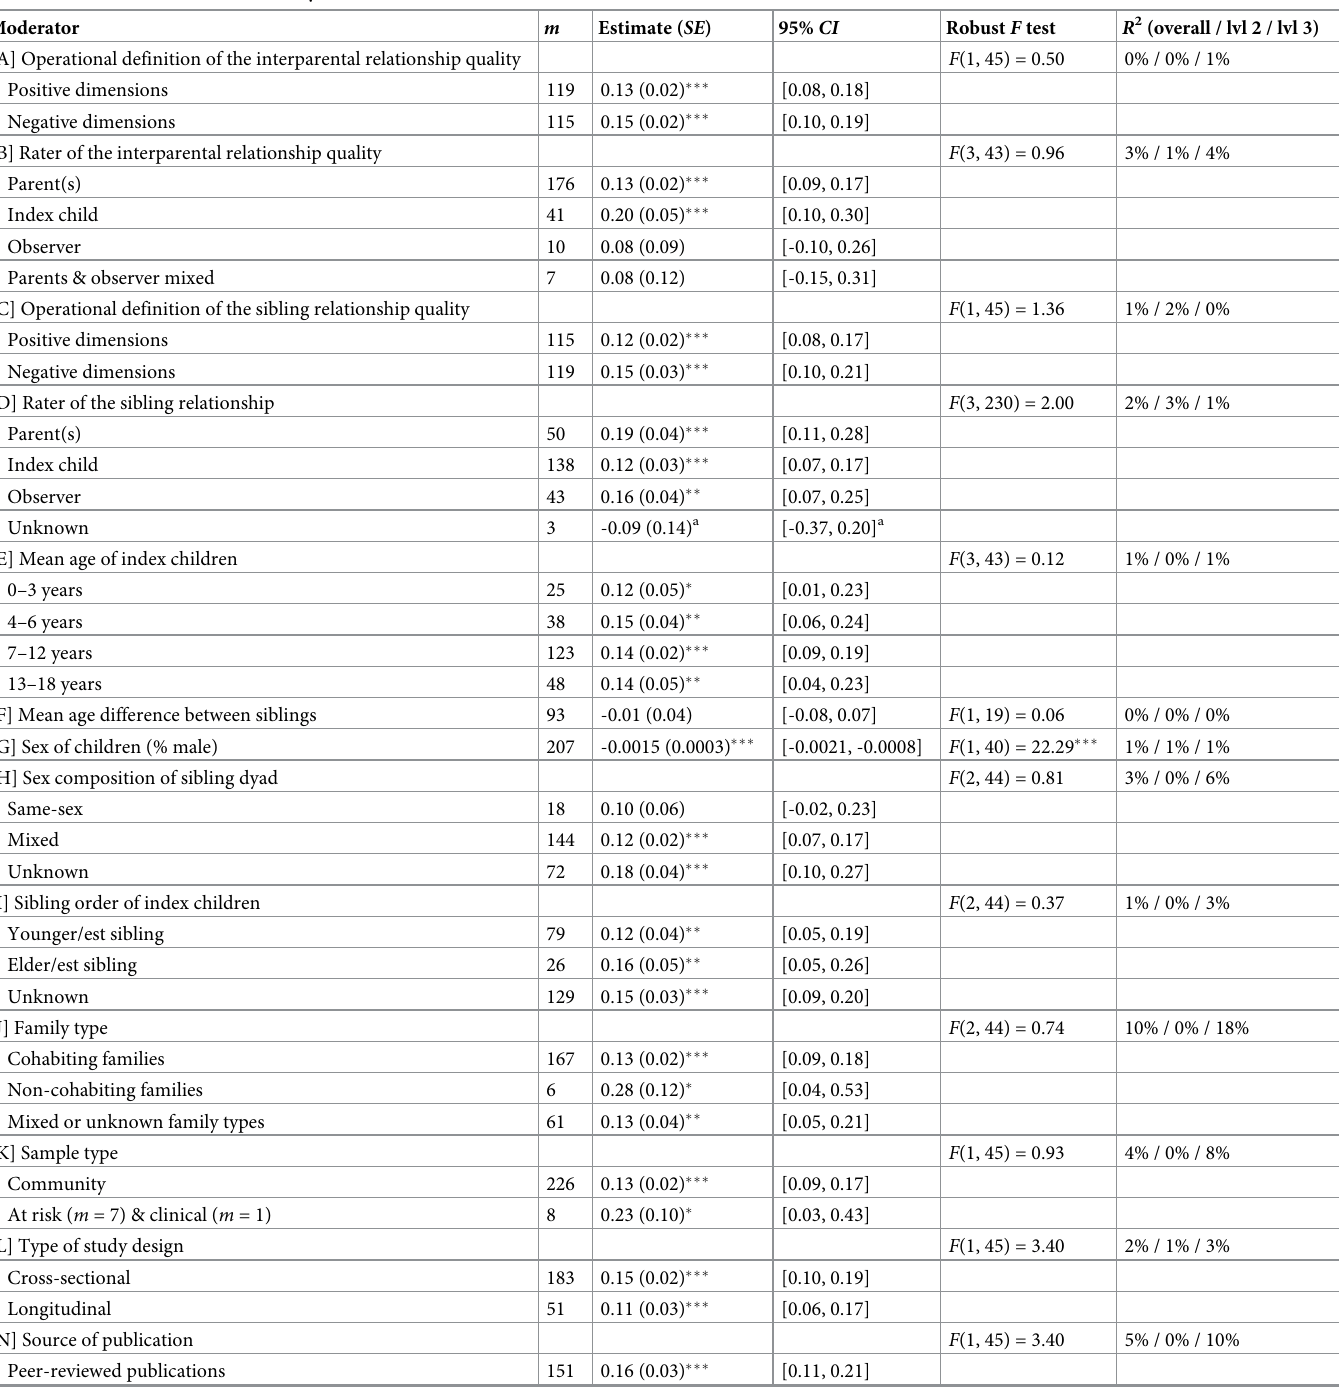
Table 2. Results of the moderator